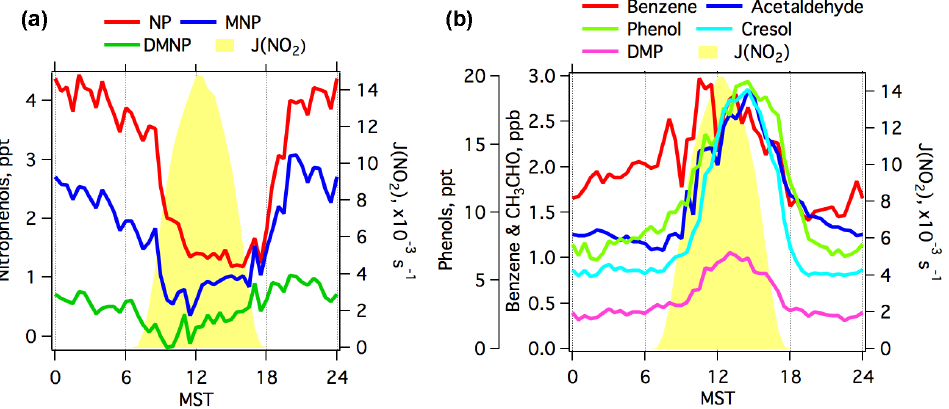
Figure 3. (a) Diurnal profiles of measured NP, MNP, and DMNP. (b) Diurnal profiles of benzene, acetaldehyde, phenol, cresol, and DMP. Photolysis frequencies of NO 2 are shown in both (a) and (b) for